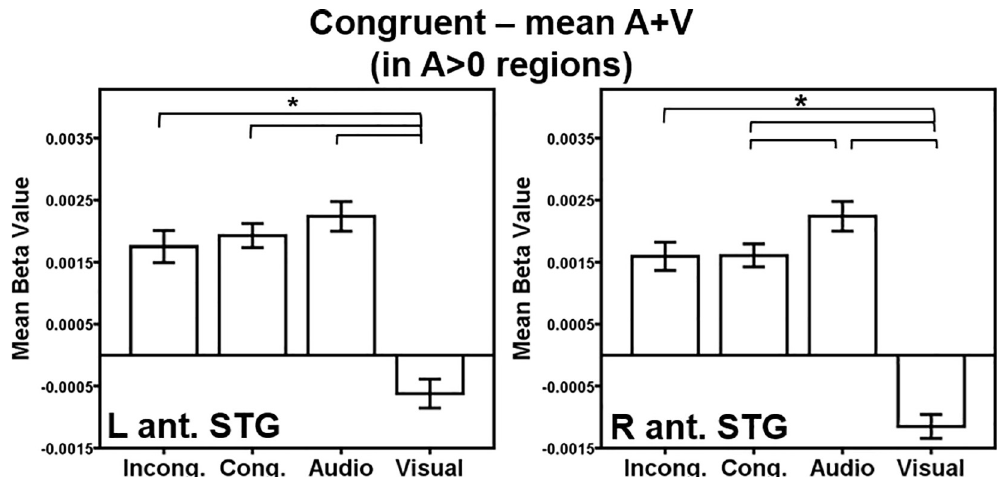
Fig 7. AV congruent within A > 0 ROI analysis. Regions of interest (ROIs) were generated from significant regions of activation in the congruent > mean of the audio- and visual-only contrasts within A > 0 regions in Fig 4. Activation within each ROI is plotted for each condition > rest. Key: L = Left, R = Right, Ant. = Anterior, STG = Superior temporal gyrus. Conditions: Incong. = Incongruent; Cong. = Congruent; Audio = Audio-only; Visual = Visual-only. Error bars represent ± 1 standard error of the mean. � p <